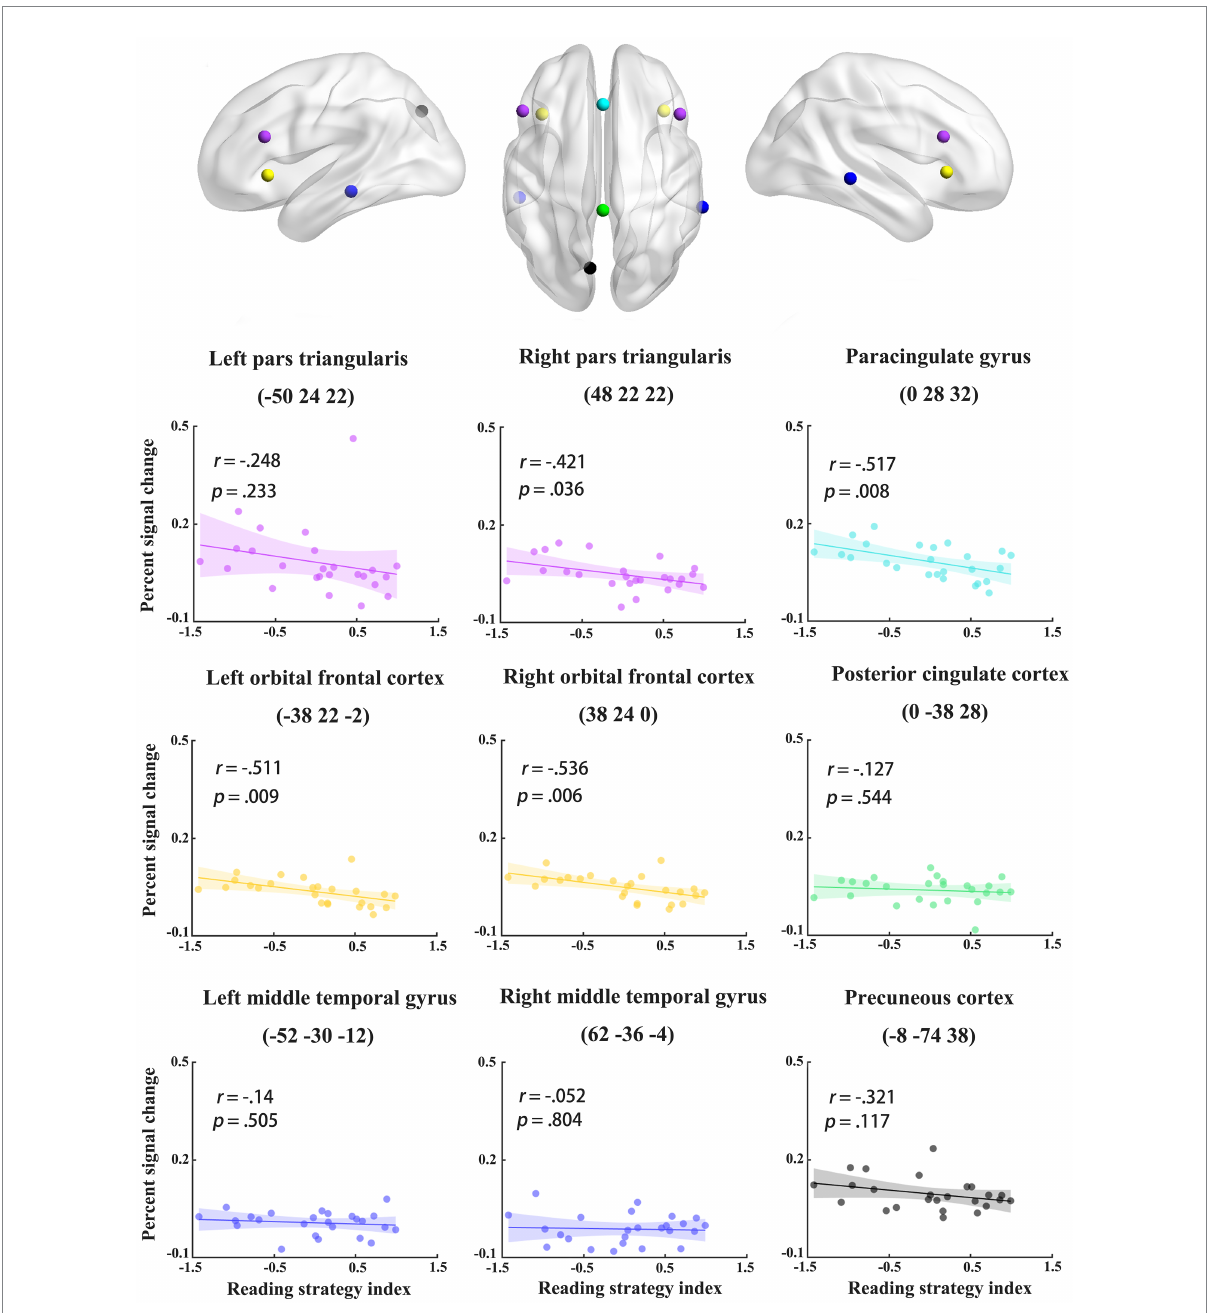
FIGURE 5 The correlations between reading strategy index and activation differences between addressed and assembled characters in the nine regions identified in multivariate pattern